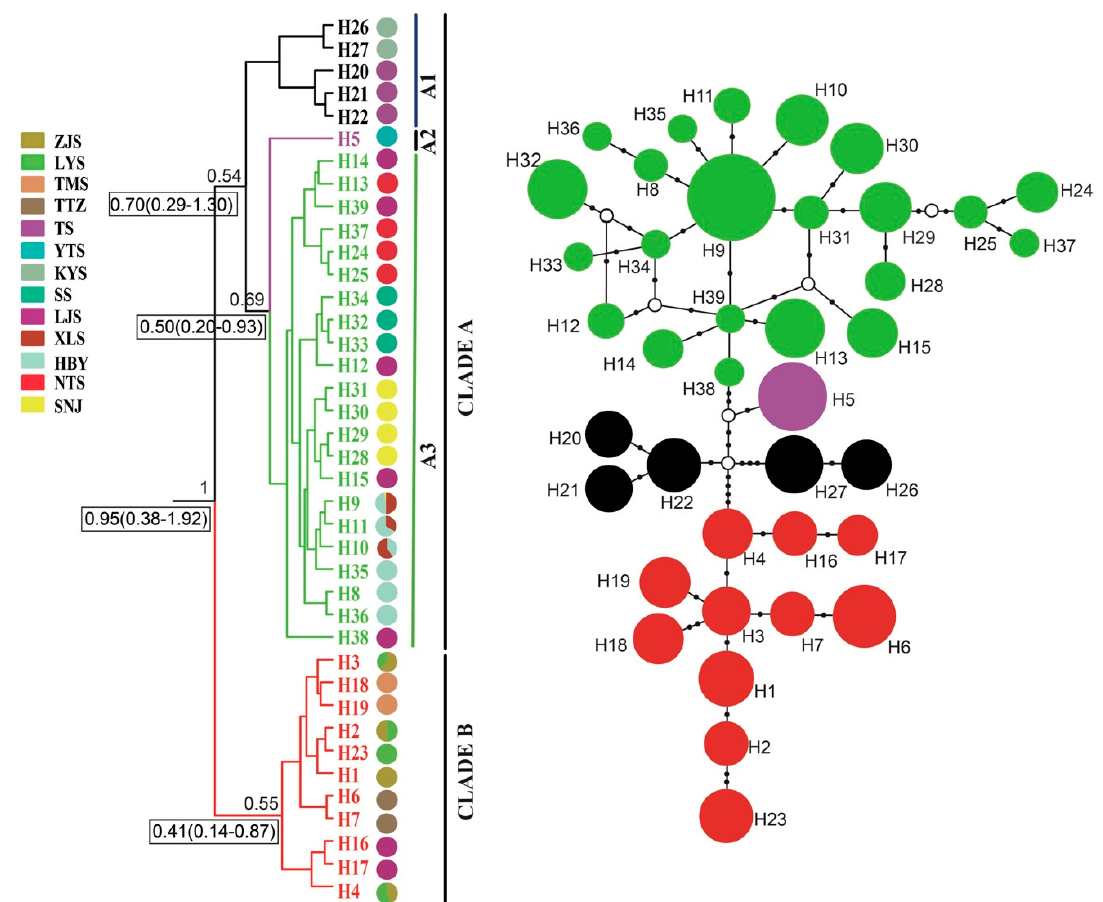
Figure 3. Bayesian phylogenetic tree (left) and median-joining network (right) based on mtDNA haplotypes of P. glacialis . Haplotype frequency denoted by circle size, black dots represent corresponding mutation steps, and open circles indicate undetected haplotypes.